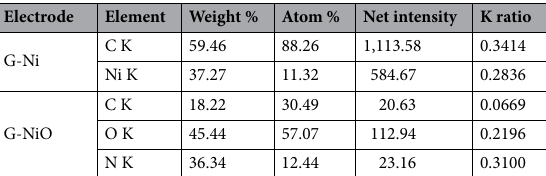
Table 1. EDS for G-Ni and G-NiO